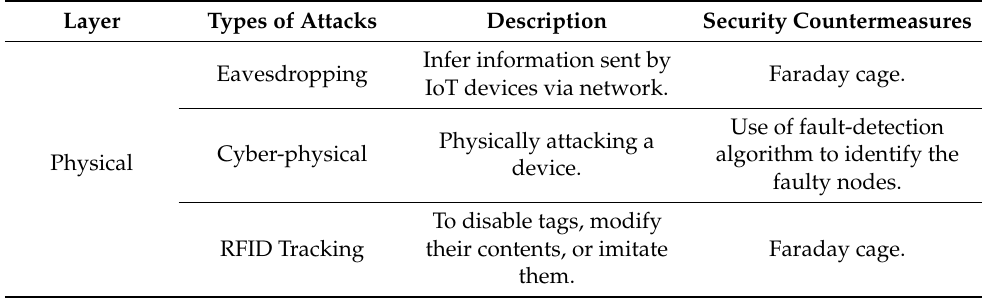
Table 6. Attacks and countermeasures on physical layer.